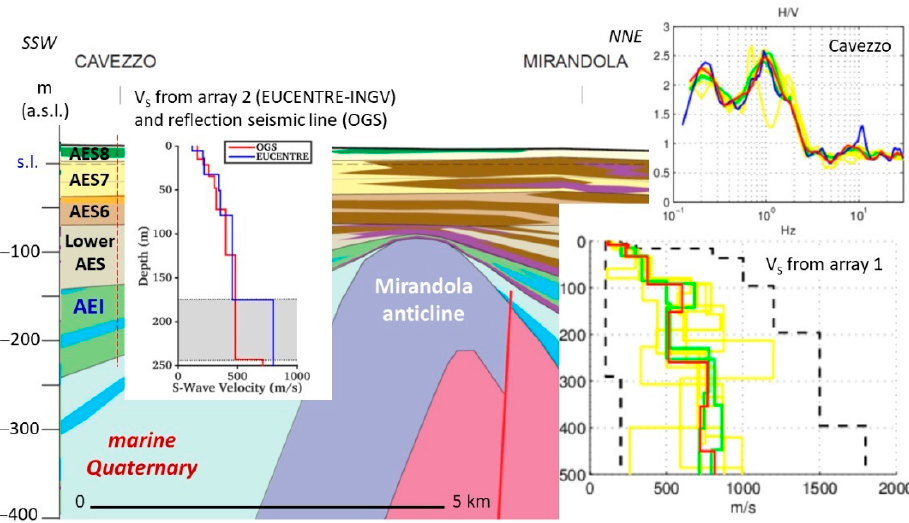
Figure 19. Geological cross-section from Cavezzo to Mirandola, H/V spectral ratio and Vs profile from ambient vibration measurement (array) in the Cavezzo urban area [19] and Vs profiles from Cavezzo seismic microzonation